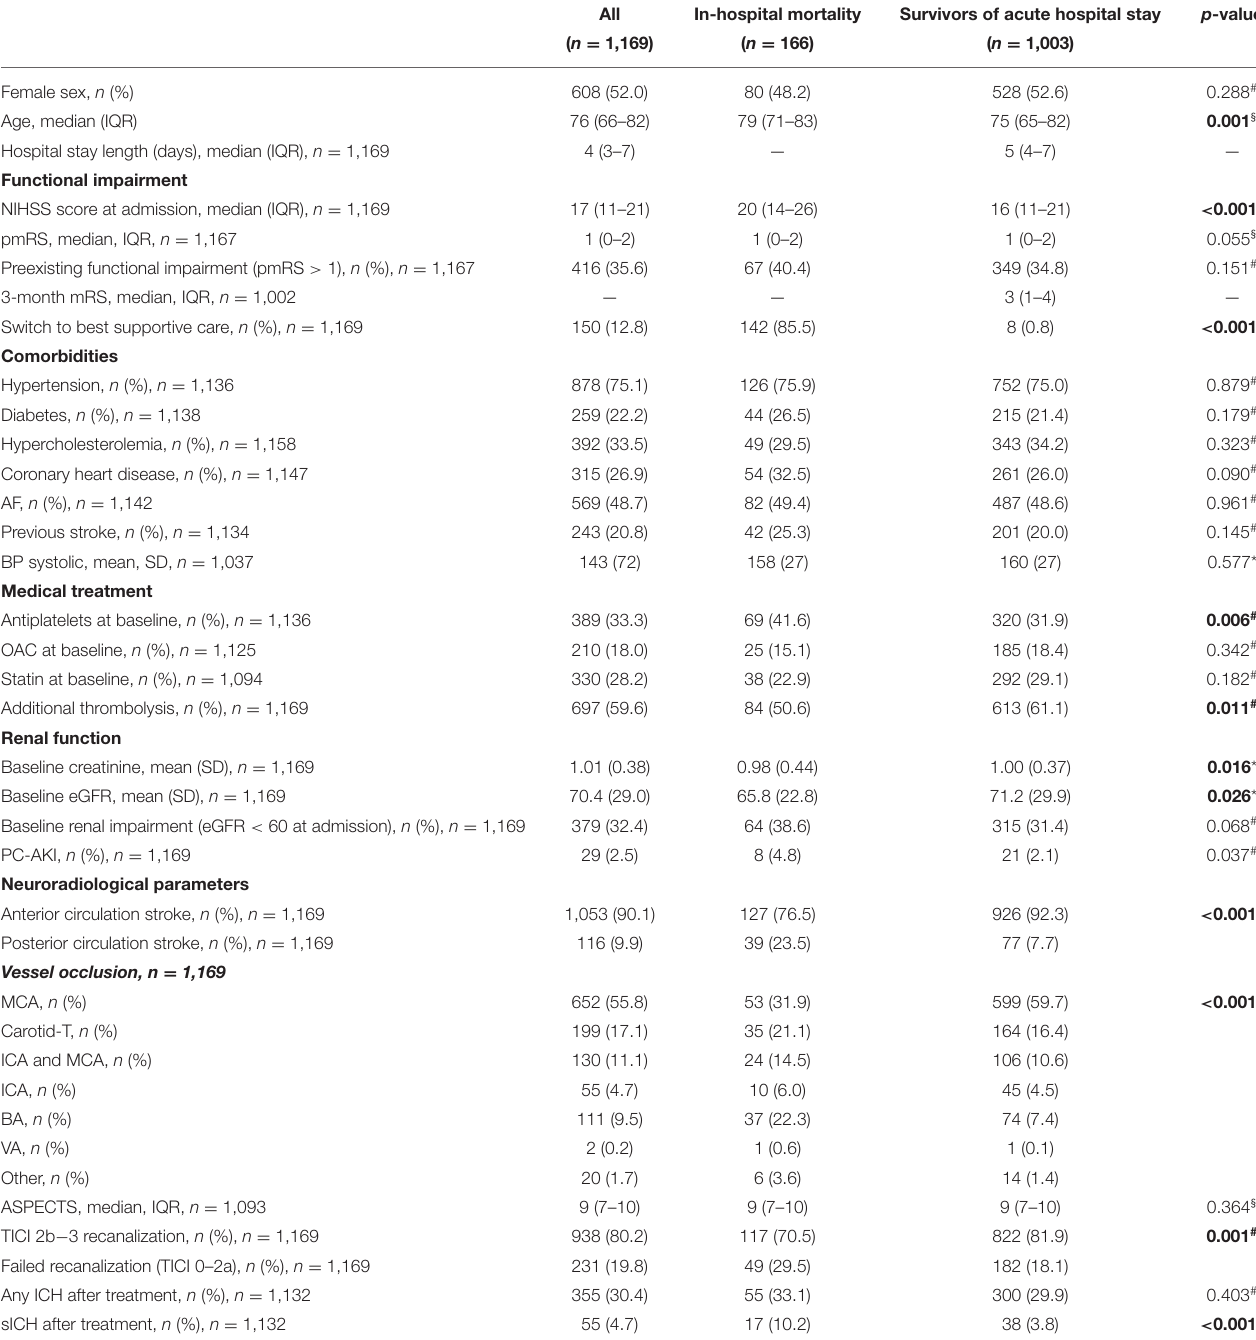
TABLE 1 | Clinical characteristics concerning in-hospital mortality vs. survivors of the acute hospital stay. All In-hospital mortality Survivors of acute hospital stay p